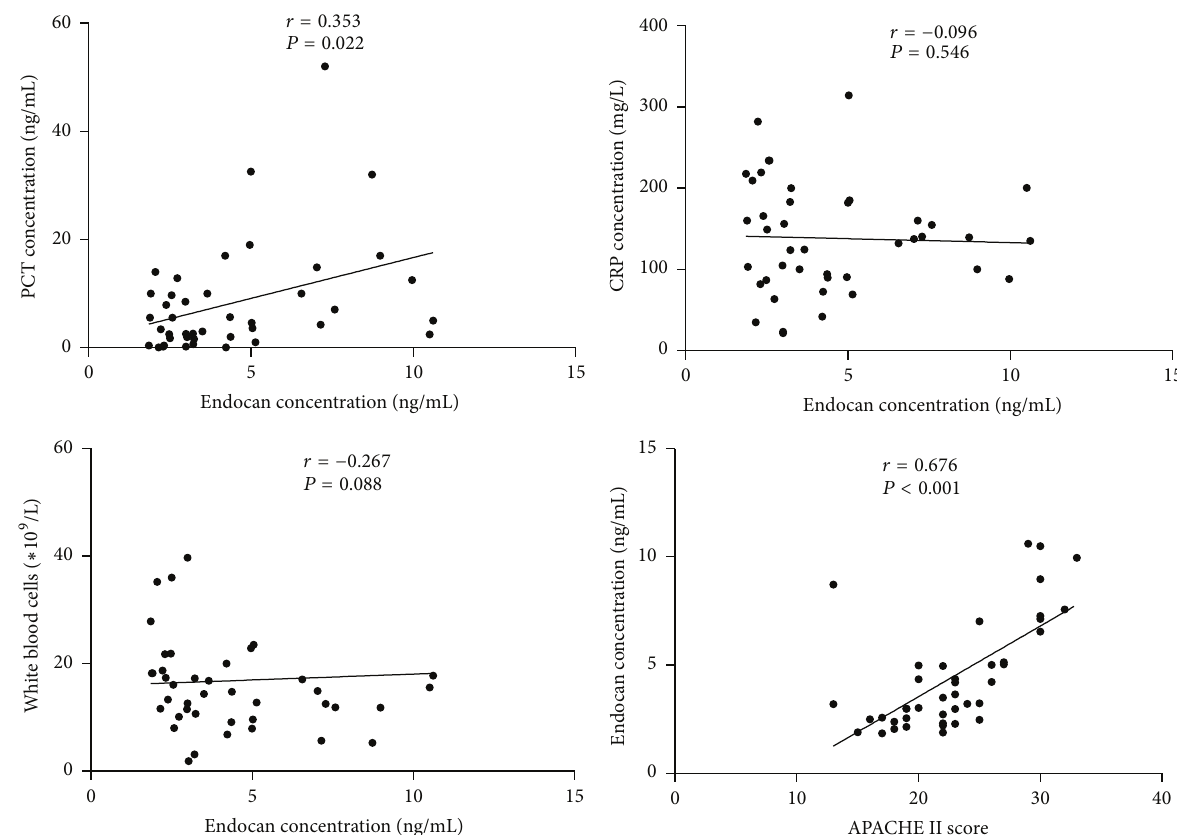
Figure 1: Correlations of plasma endocan with procalcitonin (PCT), C-reactive protein (CRP), white blood cells (WBC), and APACHE II in 42 patients with acute respiratory distress syndrome (Spearman rank analysis). 𝑟 represents Spearman’s correlation coefficients, and 𝑃 value less than 0.05 was considered statistically significant. Table 2: Comparison of plasma biomarkers between survivors and nonsurvivors of acute respiratory distress syndrome. Survivors ( 𝑁 = 22 ) Nonsurvivors ( 𝑁 = 20 ) Endocan (ng/mL), median